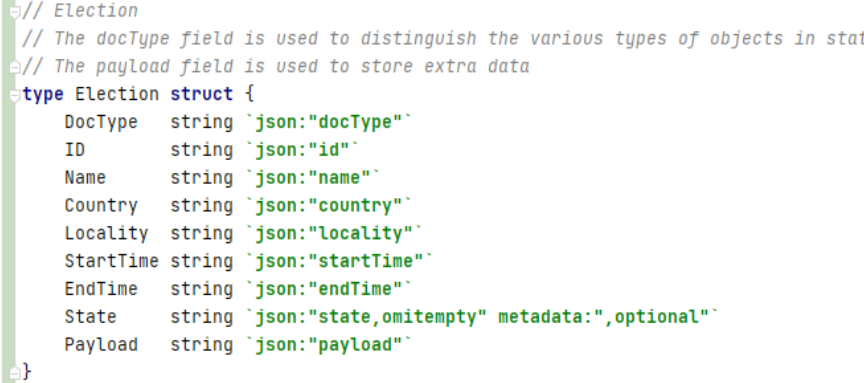
Figure 11. Election asset written in